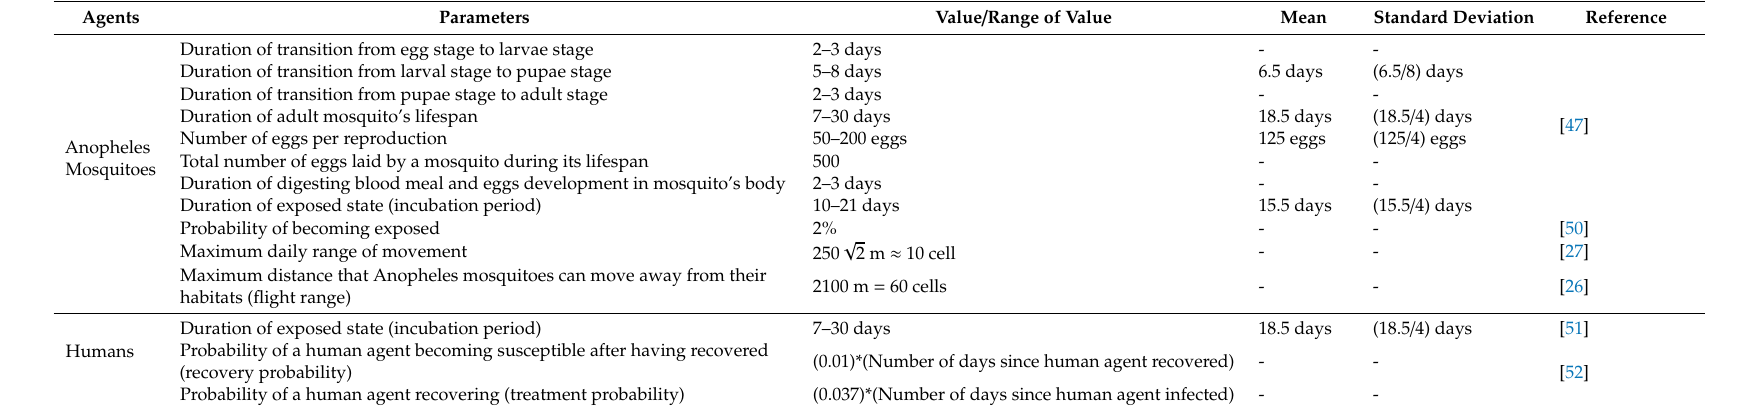
Table 2. Summary of the input